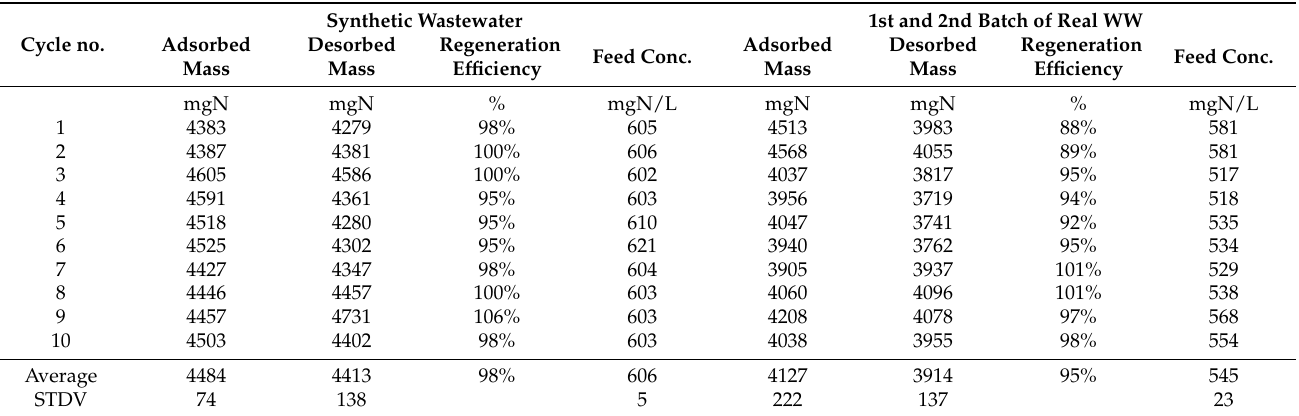
Table 5. The results obtained from the breakthrough experiments that were performed using synthetic, and 1st and 2nd batch wastewater as the feed in the adsorption